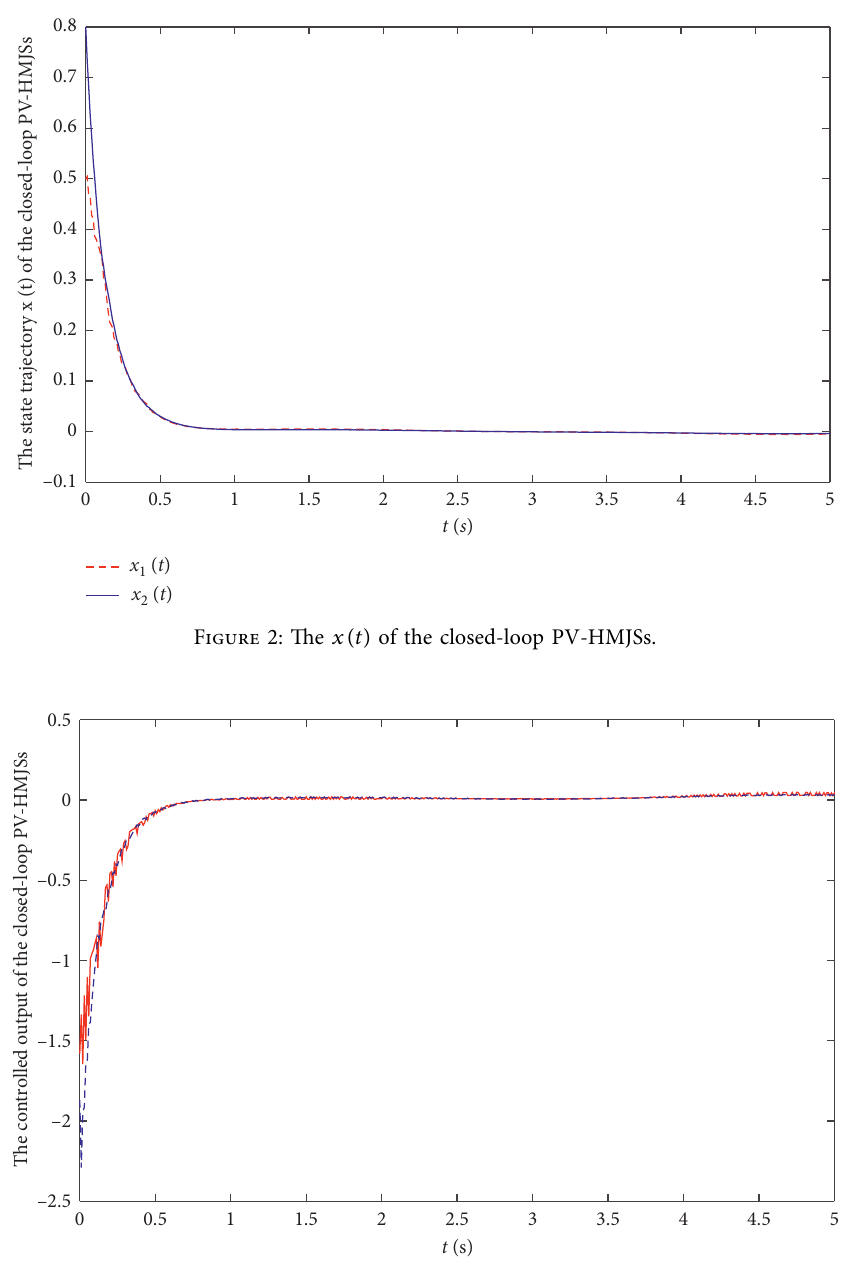
1 ( t ). (b) The jump mode of the observation state h 2 ( t ).